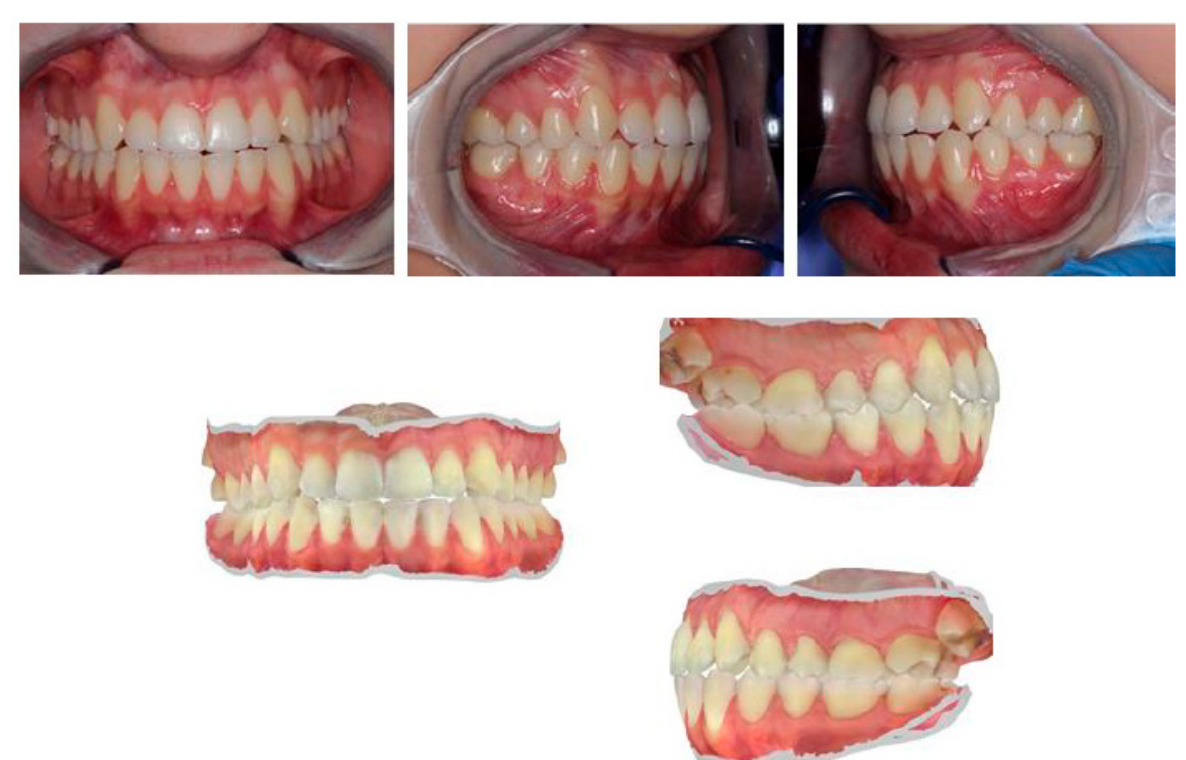
Figure 15. Extra-oral facial views. Intraoral occlusal relationships are shown in Figure 16.